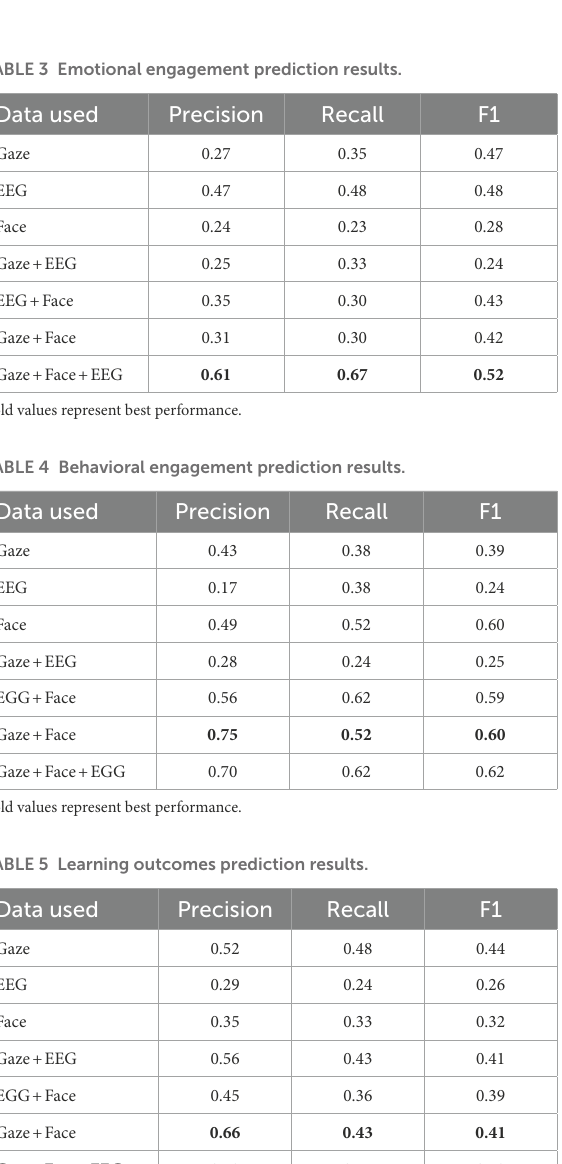
Bold values represent best